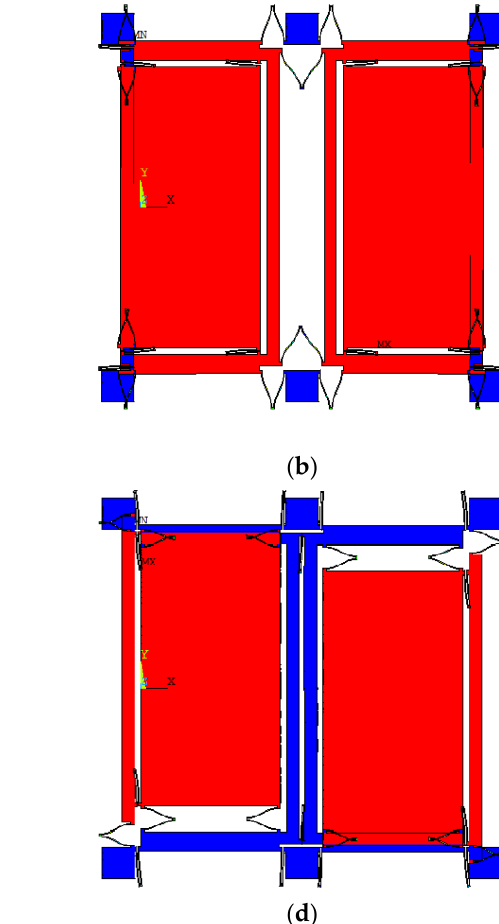
Figure 2. The four working modes of gyroscope. ( a – d ) are the four modes of the gyroscope respectively, and their corresponding frequencies are w 1 = 2623 × 2π rad/s, w 2 =3342 × 2π rad/s; w 3 = 3468 × 2π rad/s; w 4 =3484 × 2π rad/s.